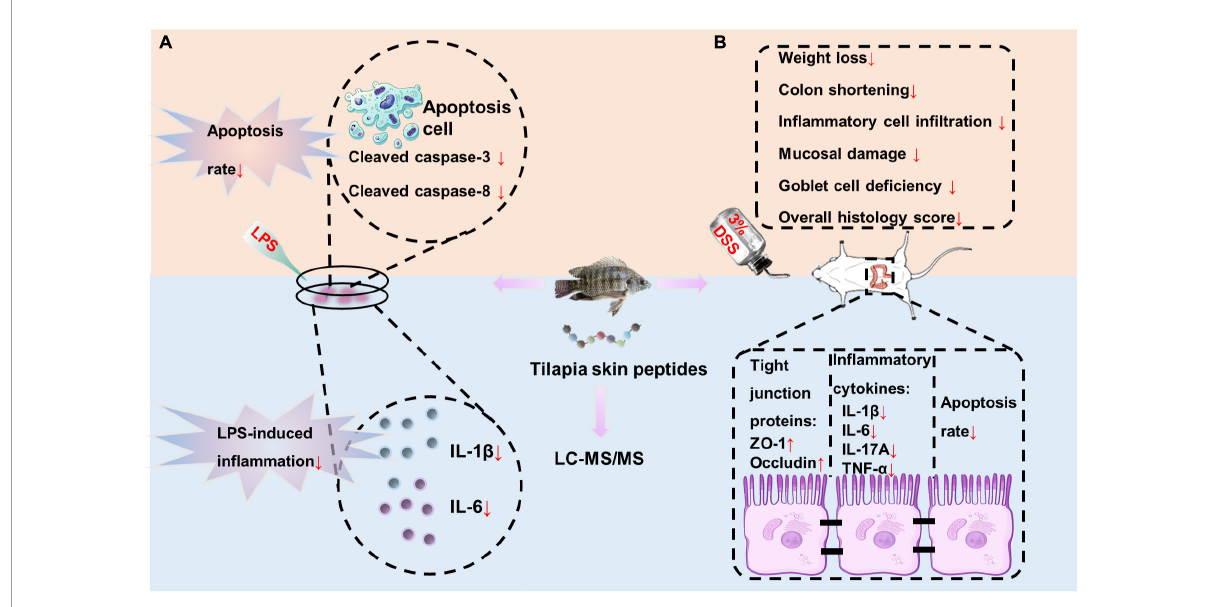
FIGURE8 Overview of TSPs inhibiting inflammation and apoptosis caused by external stimuli. (A) TSPs relieved LPS-induced inflammation and apoptosis in vitro . (B) TSPs alleviated DSS-induced inflammation and apoptosis in vivo